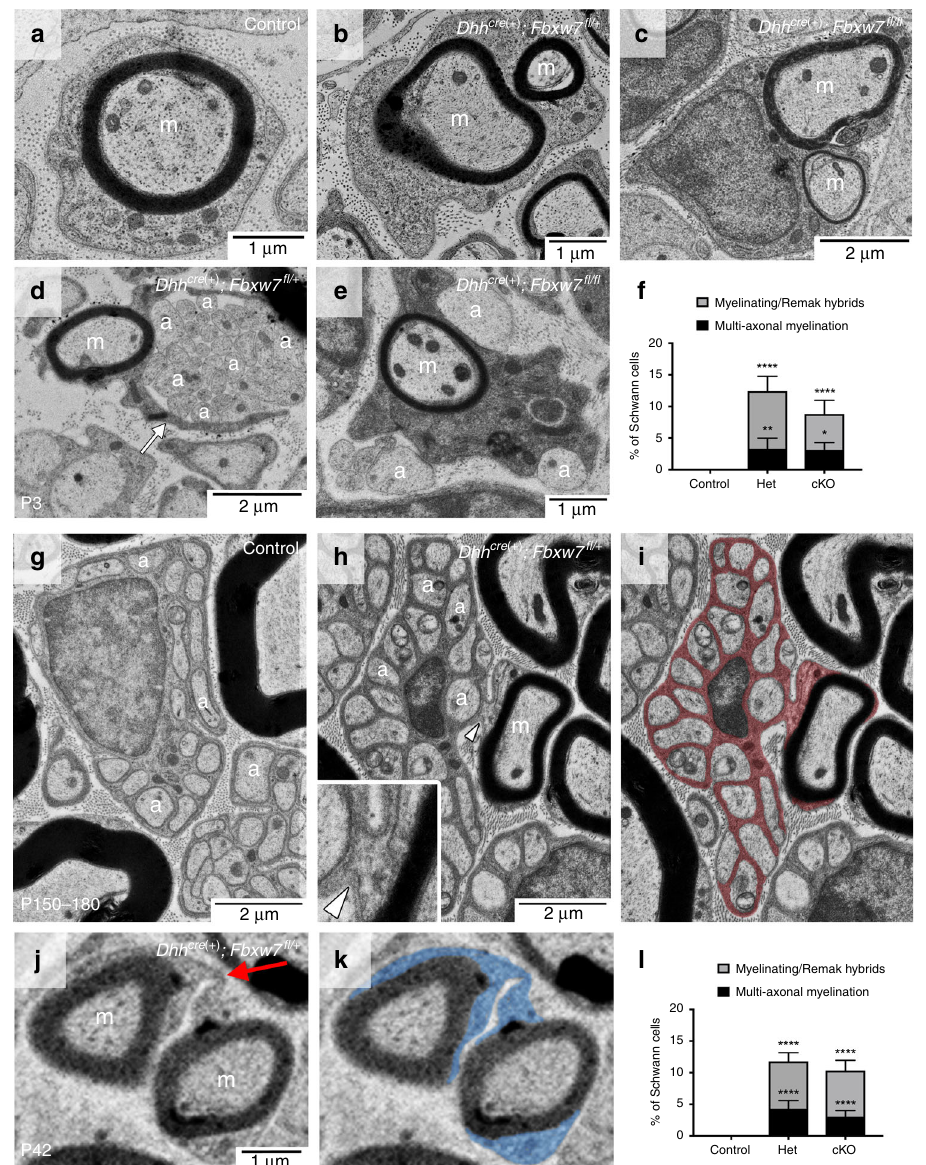
Fig. 2 Loss of Fbxw7 enhances the myelinating capacity of SCs. TEM of SC-speci fi c Fbxw7 mutant mice show aberrant SC-axon interactions as early as